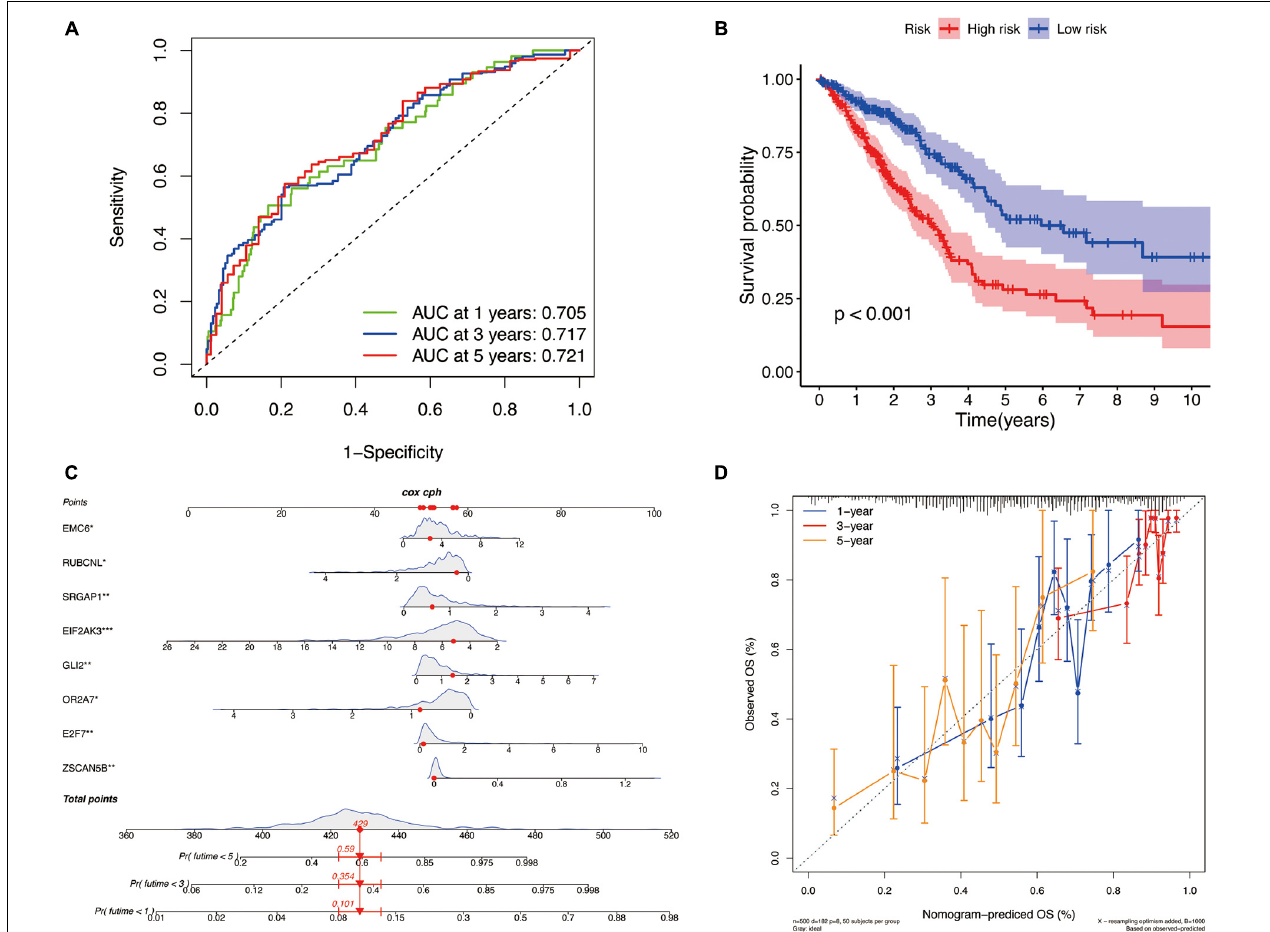
FIGURE 8 | The identification of a new prognostic signature base on the molecular subtype-related DEGs for LUAD in TCGA cohort. (A) Areas under curves (AUCs) of the risk scores for predicting 1-, 2-, and 3-year overall survival time. (B) Kaplan–Meier analysis presenting difference of overall survival between the high-risk and low-risk groups. (C) Nomogram for predicting the probability of 1-, 3-, and 5-year overall survival time for LUAD. (D) Calibration plot of the nomogram for predicting the probability of overall survival at 1-, 3-, and 5-year.